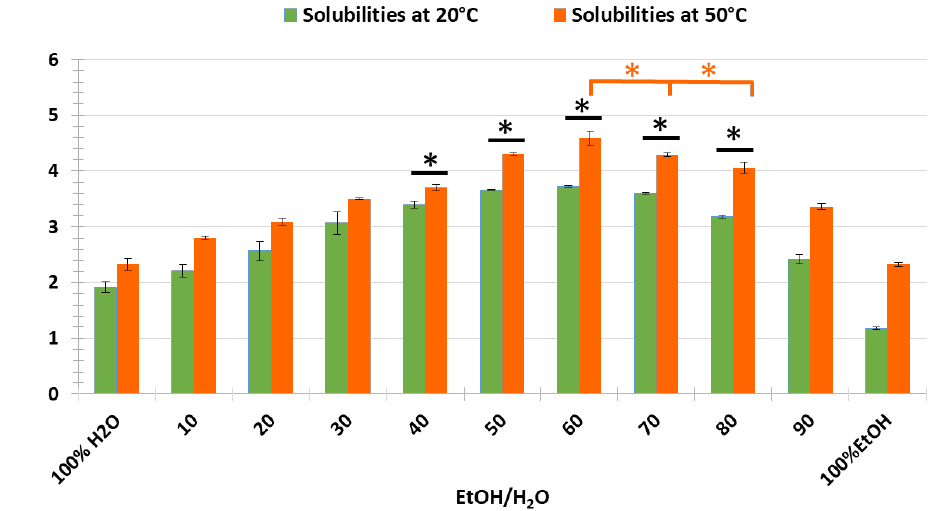
Figure 6. TPC extracted from olive pomace by CM with variation of EtOH/H 2 O ratio from 0 to 100% at 20 °C and at 50 °C; *: p ≤ 0.05 .